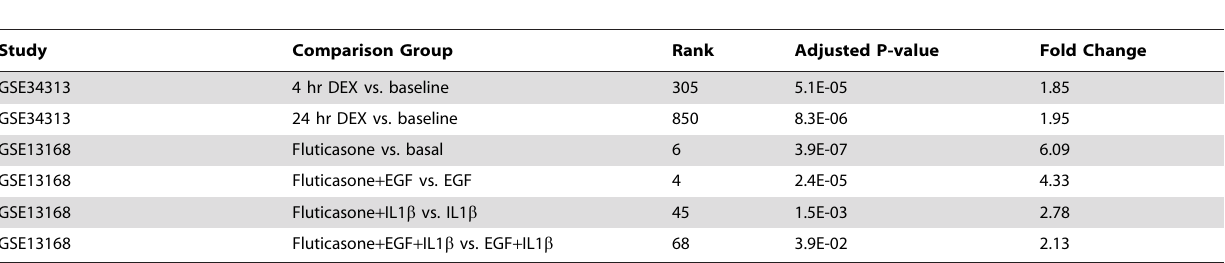
Table 3. Differential expression results for CRISPLD2 obtained from publicly available data of two previous microarray studies that investigated the effects of GCs on human ASM cells.